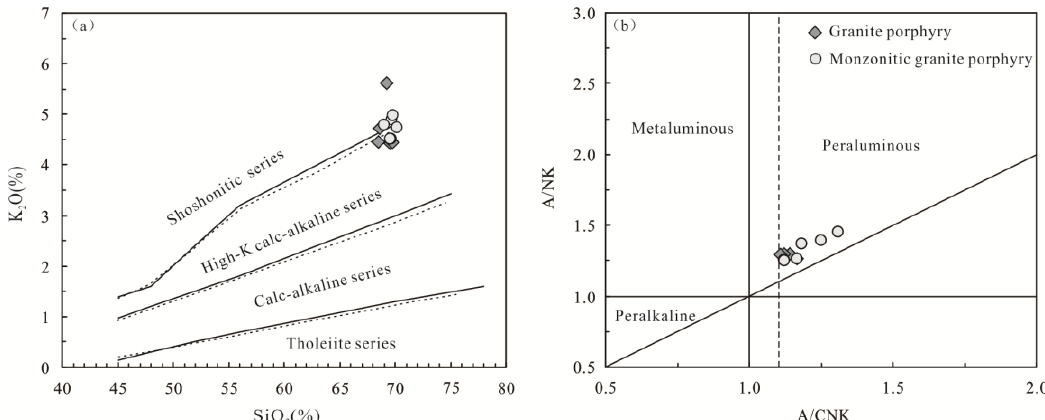
Figure 7. SiO 2 vs. K 2 O ( a ) and A/CNK vs. A/NK ( b ) diagrams of the Leimengou granite porphyry and monzonitic granite porphyry (after Rickwood,1989 [22]; Peccerillo et al.,1976 [23]).